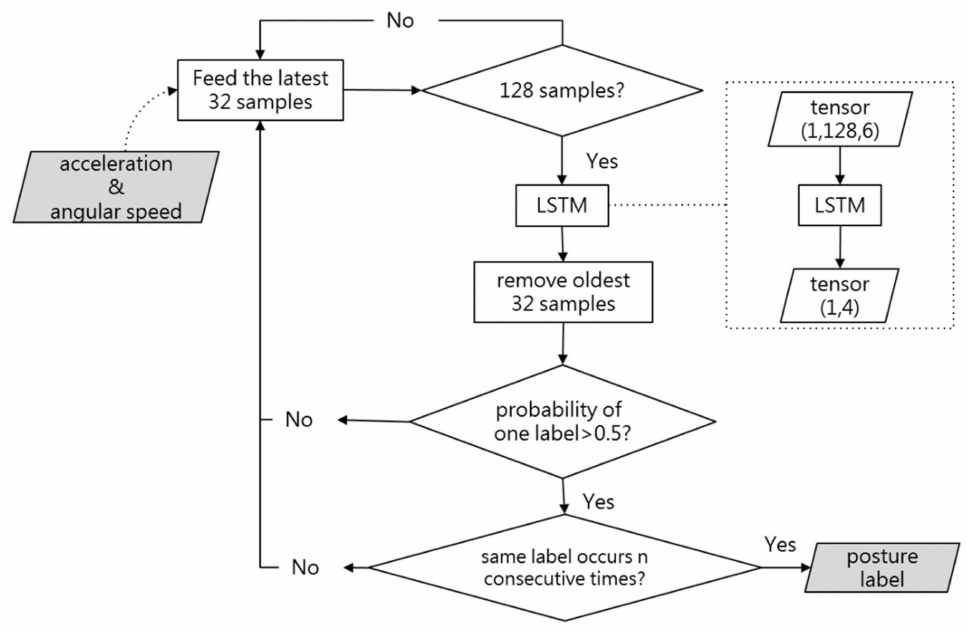
Figure 4. Flowchart of the posture recognition